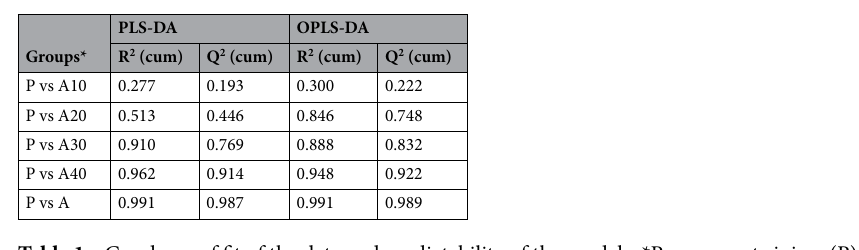
Table 1. Goodness of fit of the data and predictability of the models. *Pomegranate juices (P), apple juices (A), 10% (A10), 20% (A20), 30% (A30), 40% (A40) v/v apple/pomegranate mixtures.